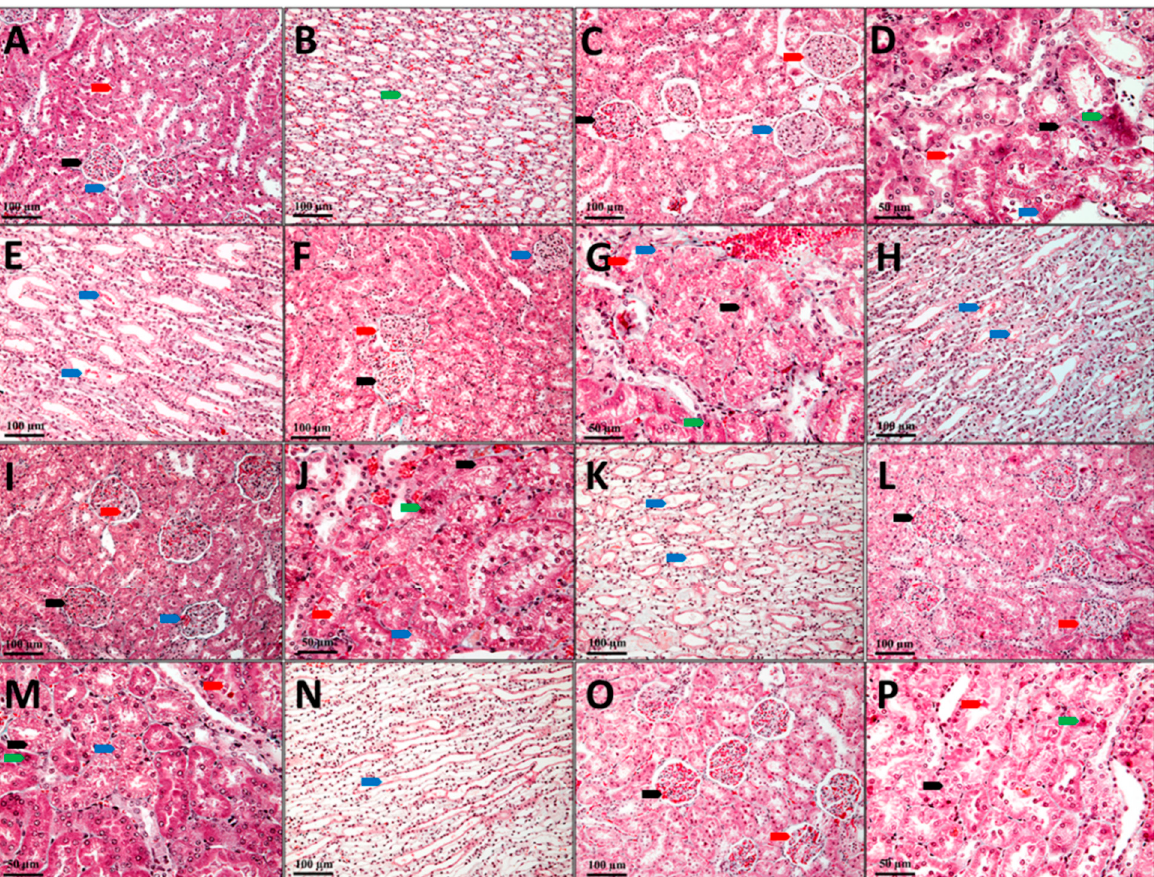
Figure 6. Kidney, Goldner trichrome coloration; ( A , B ) C, Control; ( C – E ) G, Gentamicin; ( F – H ) GCC1, Gentamicin and CC1 solution; ( I – K ) GCC2, Gentamicin and CC2 solution; ( L – N ) GLCC1, Gentamicin and LCC1 solution; ( O , P ) GLCC2, Gentamicin and LCC2 solution; ( A ), black arrow—renal corpuscle, red arrow—proximal tube, blue arrow—distal tube; ( B ), green arrow–collector tube; ( C ), black arrow—renal corpuscle with capillary ectasia, red arrow—renal corpuscle with glomerular edema, blue arrow—renal corpuscle with mesangial hyperplasia; ( D ), black arrow—nephrocytes with vacuolar degeneration, red arrow—cellular detritus in the lumen of the nephron, blue arrow—intracytolasmatic hyaline, green arrow—dead nephrocytes; ( E ), blue arrow—collector tube with protein precipitates; ( F ), black arrow—renal corpuscle with capillary ectasia, red arrow—renal corpuscle with glomerular edema, blue arrow—renal corpuscle with mesangial hyperplasia; ( G ), black arrow—nephrocytes with vacuolar degeneration, red arrow—cellular detritus in the lumen of the nephron, blue arrow—intracytolasmatic hyaline, green arrow—dead nephrocytes; ( H ), blue arrow—collector tube with protein precipitates; ( I ), black arrow—renal corpuscle with capillary ectasia, red arrow—renal corpuscle with glomerular edema, blue arrow—renal corpuscle with mesangial hyperplasia; ( J ), black arrow—nephrocytes with granulo-vacuolar degeneration, red arrow—cellular detritus in the nephron lumen, blue arrow—intracytolasmatic hyalinosis, green ar- row—dead nephrocytes; ( K ), blue arrow—collector tube with protein precipitates; ( L ), black arrow—nephrocytes with vacuolar degeneration, red arrow—cellular detritus in the lumen of the nephron; ( M ), black arrow—nephrocytes with vacuolar degeneration, red arrow—cellular detritus in the lumen of the nephron, blue arrow—in-tracytolasmatic hyaline, green arrow—dead nephrocytes; ( N ), blue arrow—collector tube with protein precipitates; ( O ), black arrow—renal cor- puscle with capillary ectasia, red arrow—renal corpuscle with glomerular edema; ( P ), black arrow—nephrocytes with granular degeneration, red arrow—cellular detritus in the nephron lumen, green arrow—dead nephrocytes.